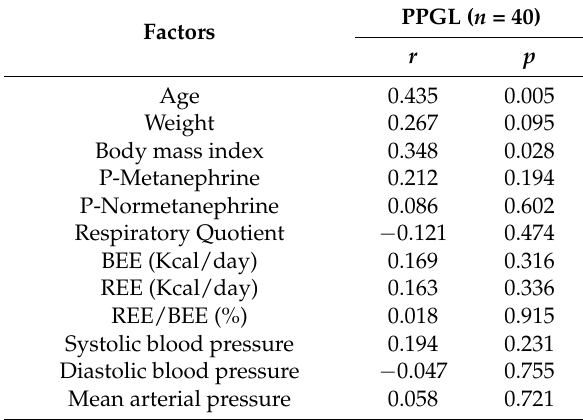
Table 3. Selected factors associated with serum FGF21 levels in PPGL